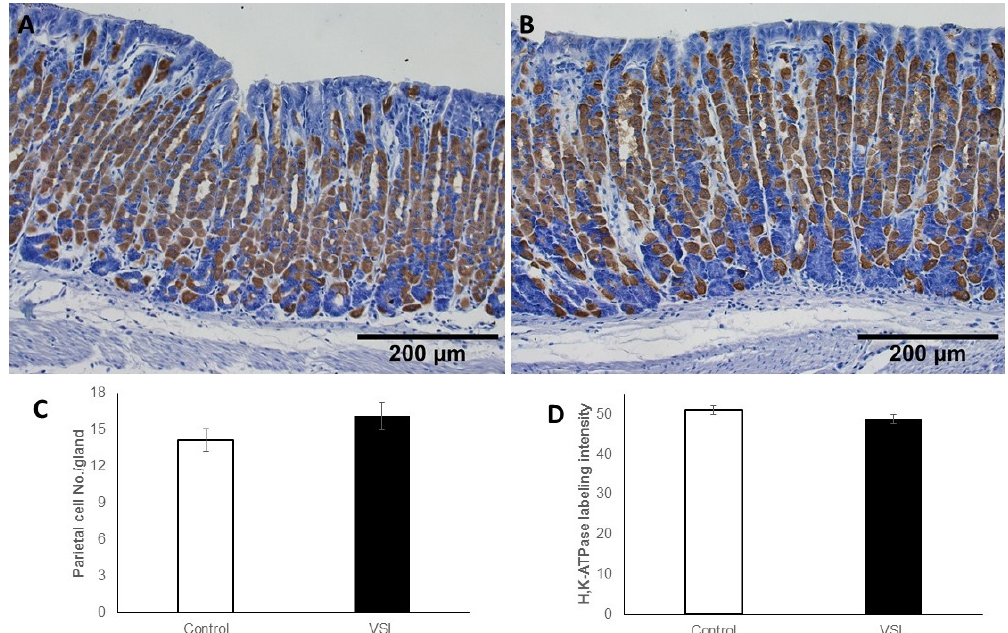
Figure 10. Immunohistochemical labeling of parietal cells in the gastric mucosa of control ( A ) and VSL-treated ( B ) mice with antibodies specific for H + ,K + -ATPase β -subunit. Labeled parietal cells are distributed throughout the gastric glands. Magnification bar = 200 µm. Quantification of H + ,K + -ATPase-labeled cells per gland ( C ) and the labeling intensity per field ( D ) in seven control and seven VSL-mice are presented as mean ± SE. No significant differences were observed.